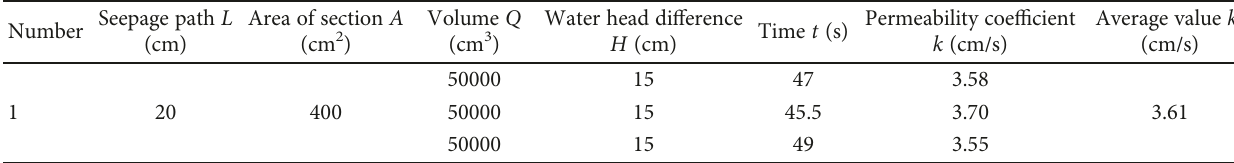
Table 3: Results of the penetration test for a fractured rock mass ( ξ = 0 8 ).